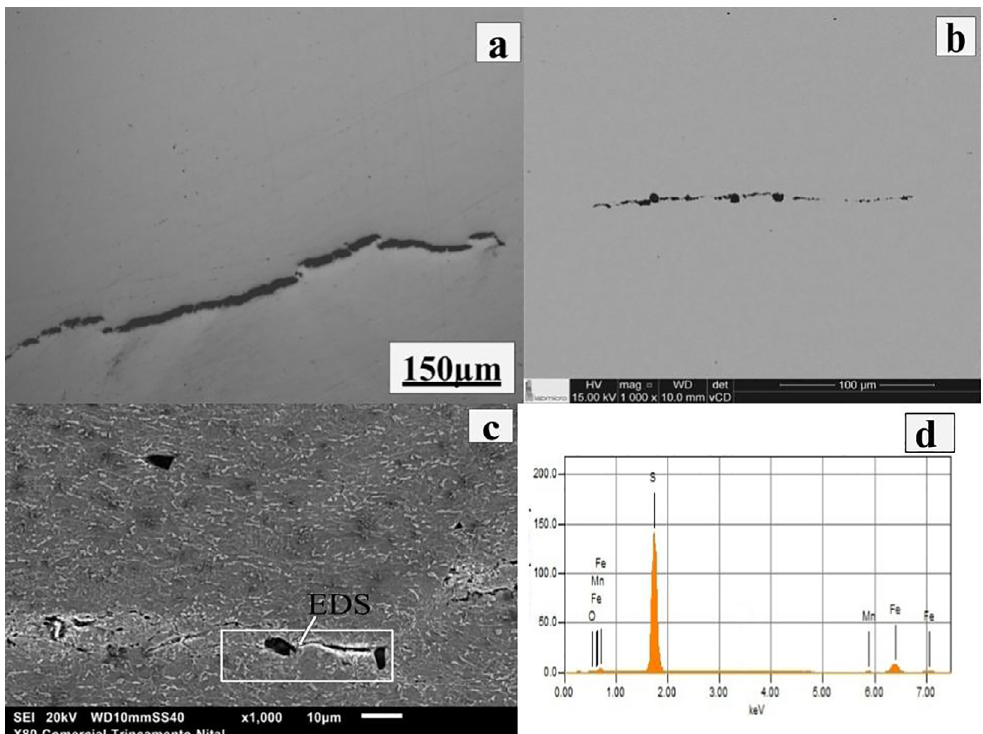
Figure 15. OM (a) and SEM (backscattered electrons) (b) images of one of the API 5L X80 samples submitted to the HIC test. Polished (1 µm) cross-section to the rolling direction. Sample after Nital 2% etching (c), EDS analysis of the inclusion indicated in (c) (d). Exposure time 96h to solution A saturated with H 2